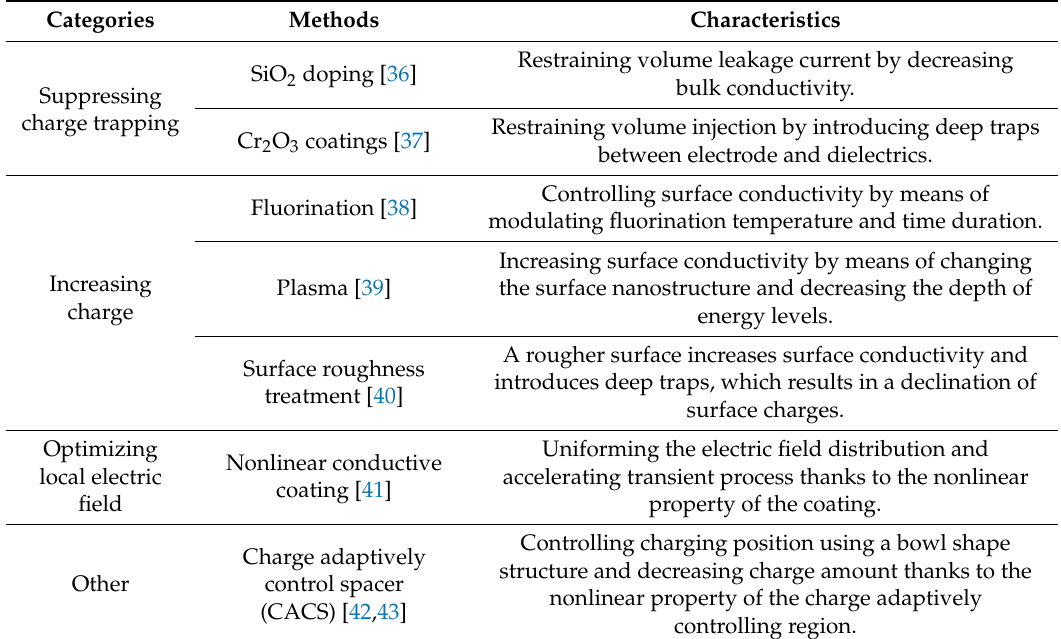
Table 2. Representative works of di ff erent modification methods and their